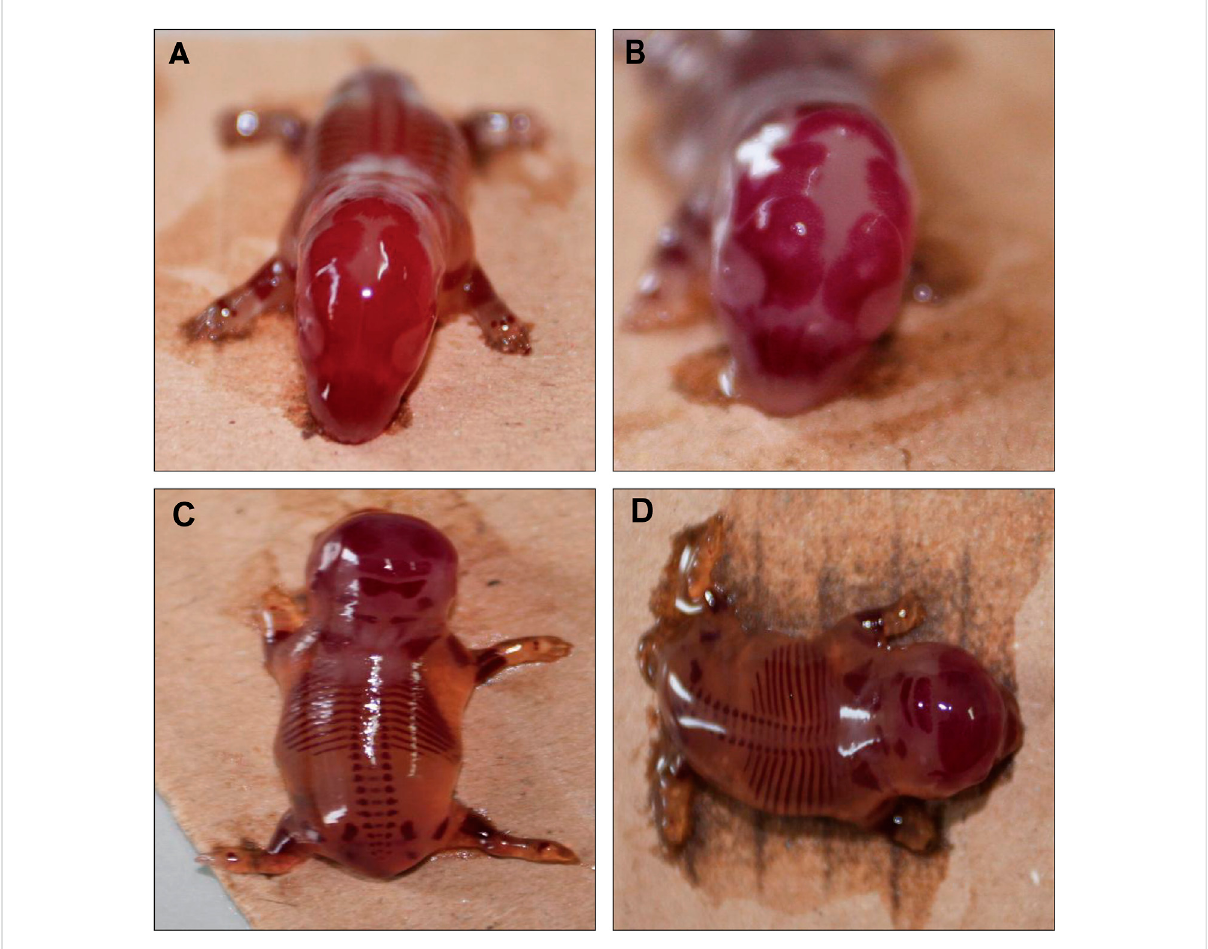
FIGURE 4 EffectofMPTAonskeletaldeformitiesinfetalrats (A) Normalskull; (B) delayedskullossi fi cation; (C) normaloccipitalbone; (D) delayedoccipital ossi fi